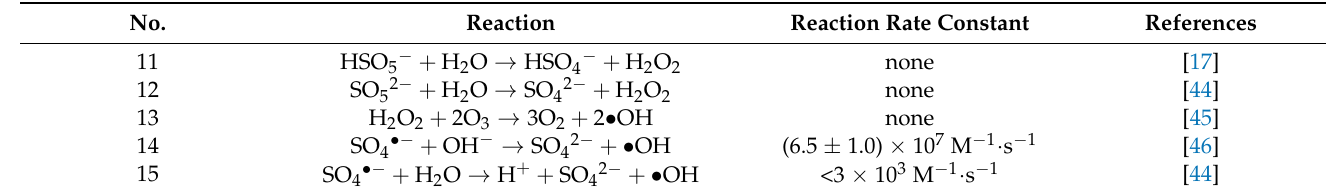
Table 2. Reaction equations and corresponding reaction rate constants for PMS- and SO 4 •−